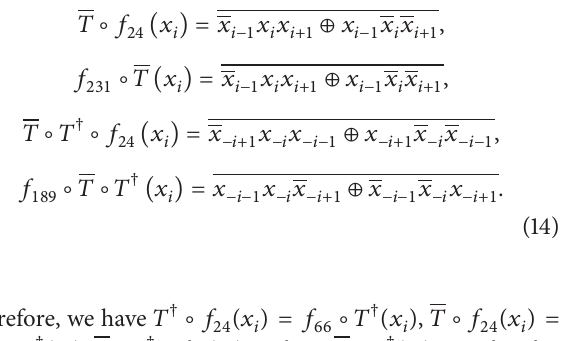
Figure 2: Let 𝐼 = 14 . (a), (b), and (c) describe the process, where all points fall into Bernoulli-shift map after two iterations under rule 24.